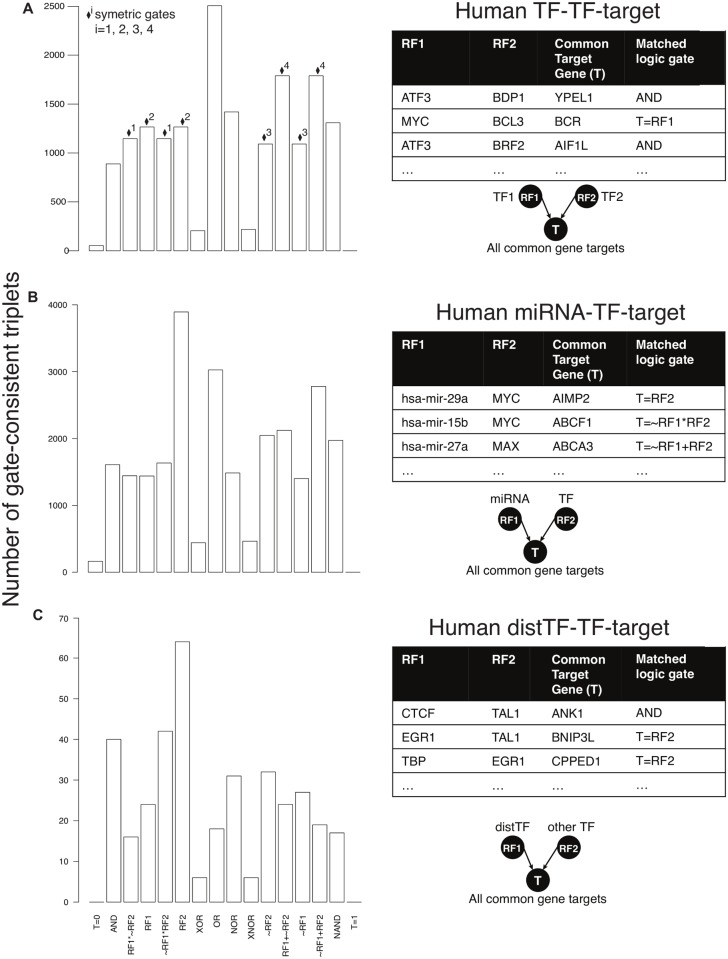
Distributions by logic gate of all gate-consistent human regulatory triples in acute myeloid leukemia.
A—TF-TF-target triplets. The symmetric gate pairs are marked using diamonds on top of bars with identical superscript numbers; B—miRNA-TF-target triplets; C—distTF-TF-triplets. The triplets from B and C have different distributions from A, including notably at symmetric gates because their RF1s are miRNA/distTF. Also, the “T = RF2” gate matches more triplets than any other gate in B and C.